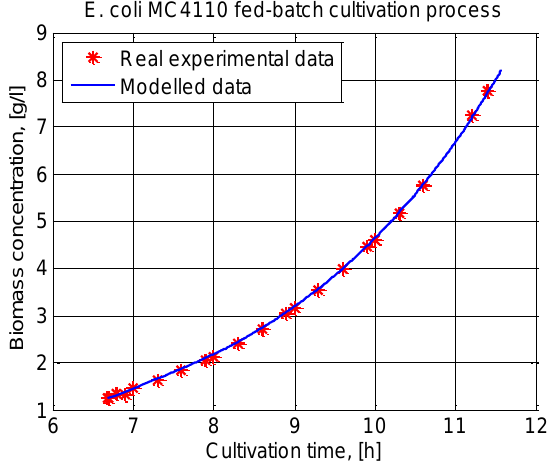
Figure 3. Time profiles of the process variable biomass: real experimental data and model predicted data.